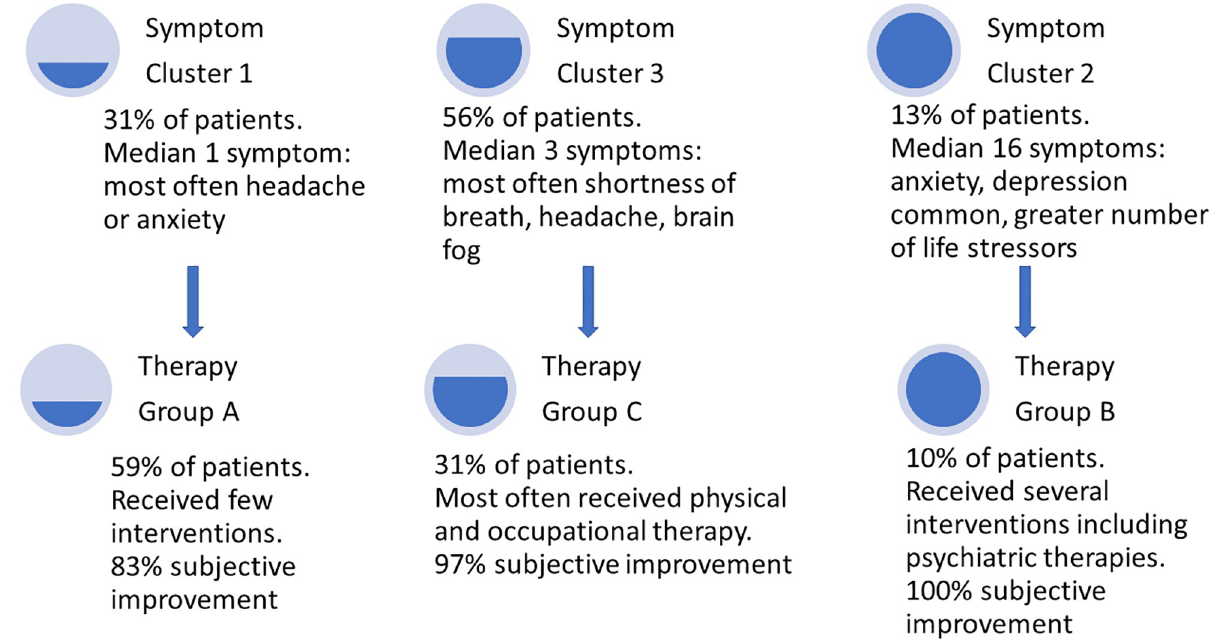
Fig 4. Relationship of symptom clusters and therapy groups (N = 122). Symptom Cluster 1 was significantly related to membership in Therapy Group A (Odds Ratio [OR] 2.55, 95% confidence interval [CI] 1.10–5.89), Symptom Cluster 2 was associated with Therapy Group B (OR 15.70, 95% CI 4.14–59.70) and Symptom Cluster 3 was associated with Therapy Group C (OR 3.08, 95% CI